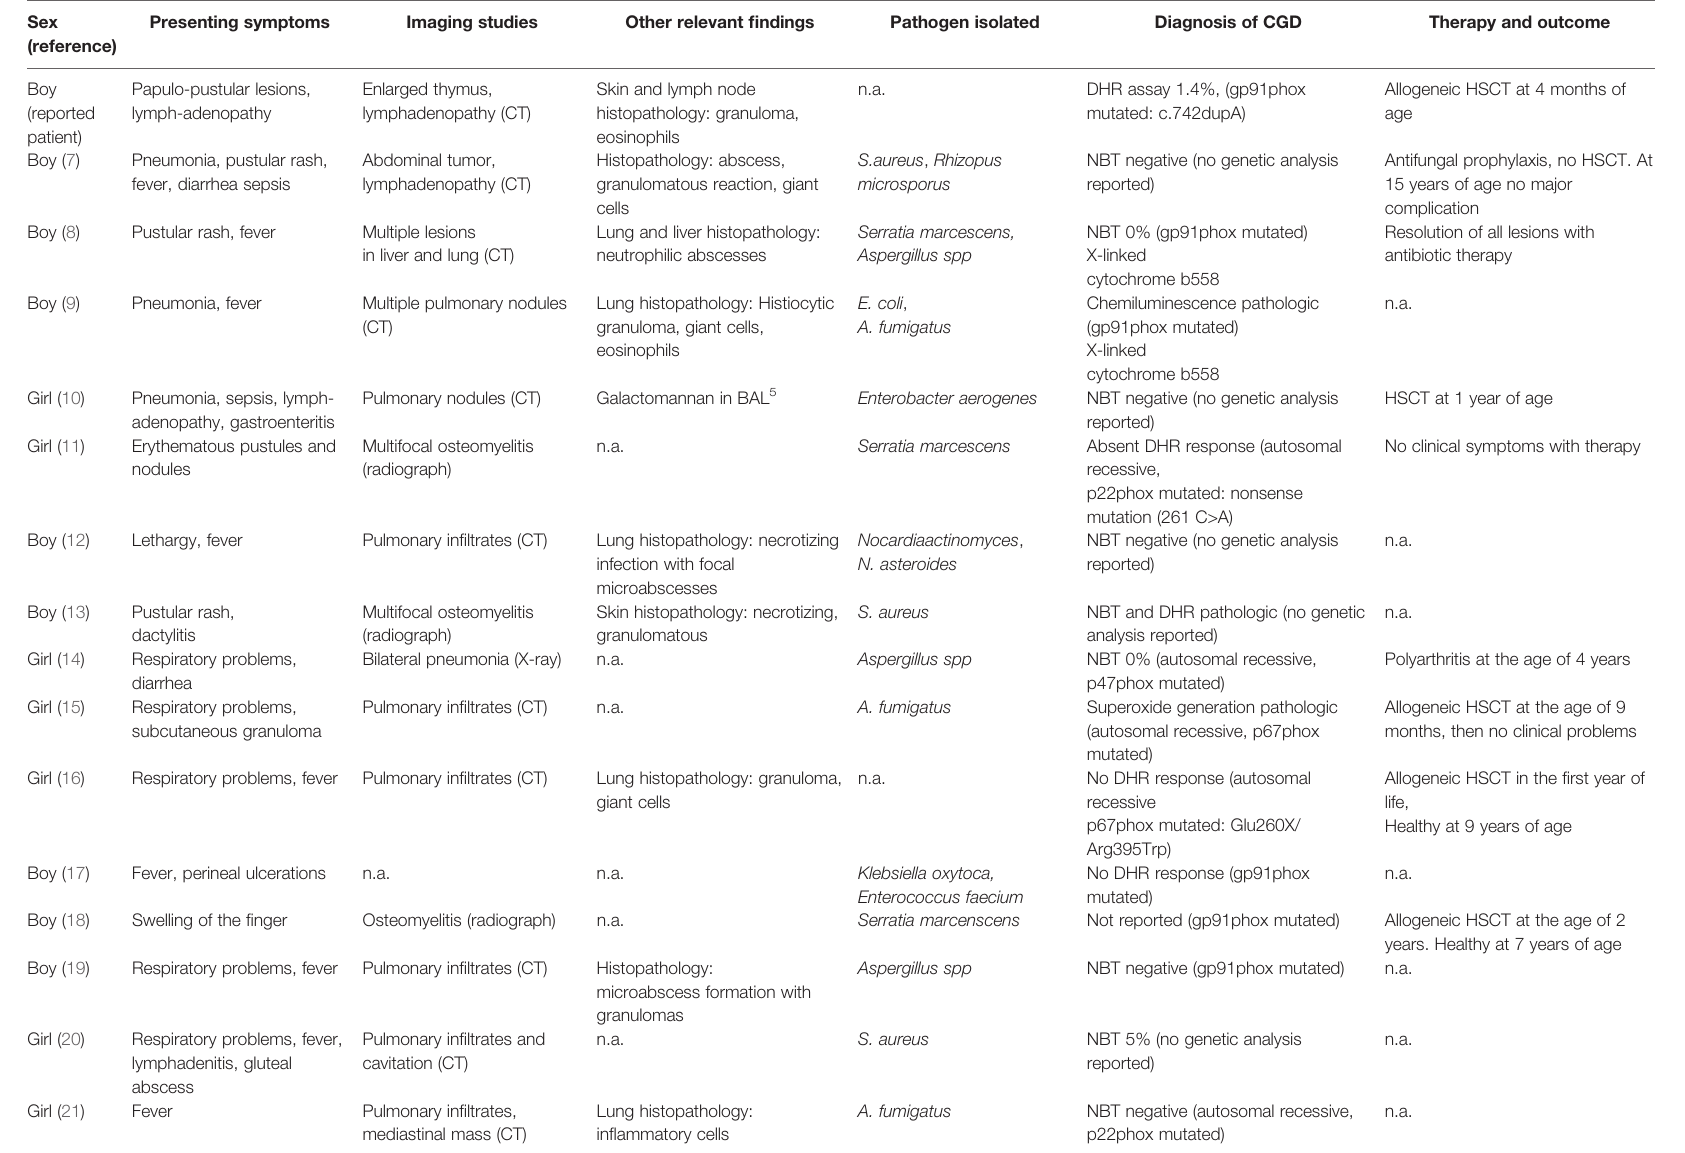
TABLE 1 | Summary of patients reported in the literature with onset of chronic granulomatous disease (CGD) within the fi rst six weeks of life. Sex